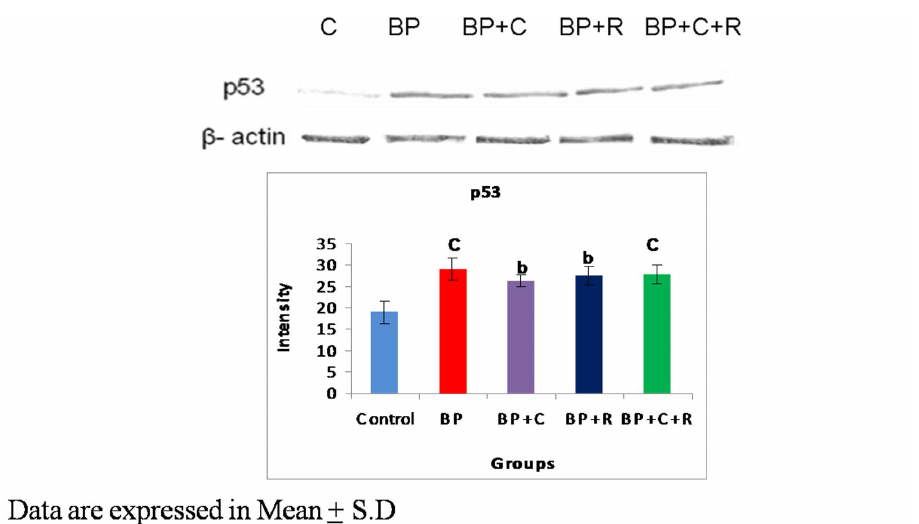
Figure 2. Effects of curcumin and resveratrol on protein expression of p53 by western blot analysis during lung carcinogenesis. doi:10.1371/journal.pone.0093820.g002 PLOS ONE |